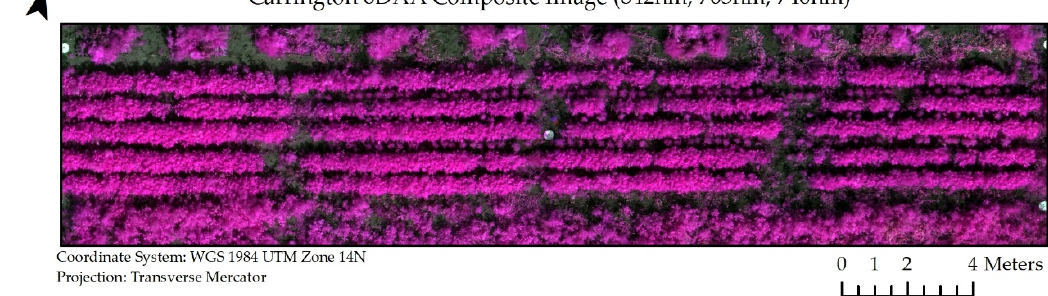
The kappa coefficient values for kochia at 4 DAA suggested only slight agreement Weeds at best between the classification and ground truth fields of wavelength combination The MoR of resistance did not have any variation within the respective species as the 705 nm, 740 nm, and 842 nm at the Casselton location (Table 5). The wavelengths in waterhemp population was determined to be completely resistant to the glyphosate